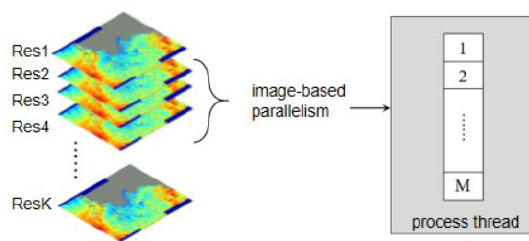
Figure 7. The parallelism on the image level for phase unwrapping processing.